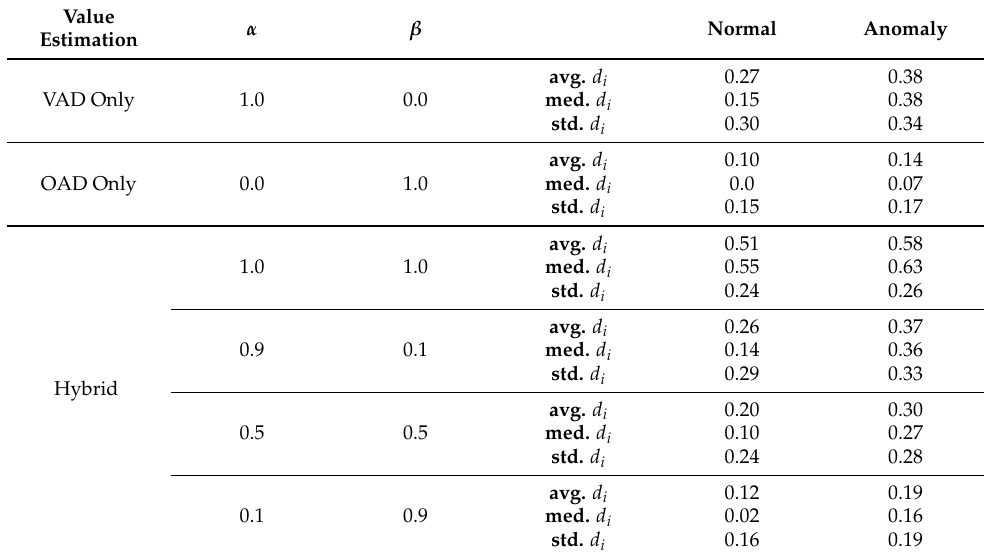
Table 7. Compression quality decisions for hybrid value